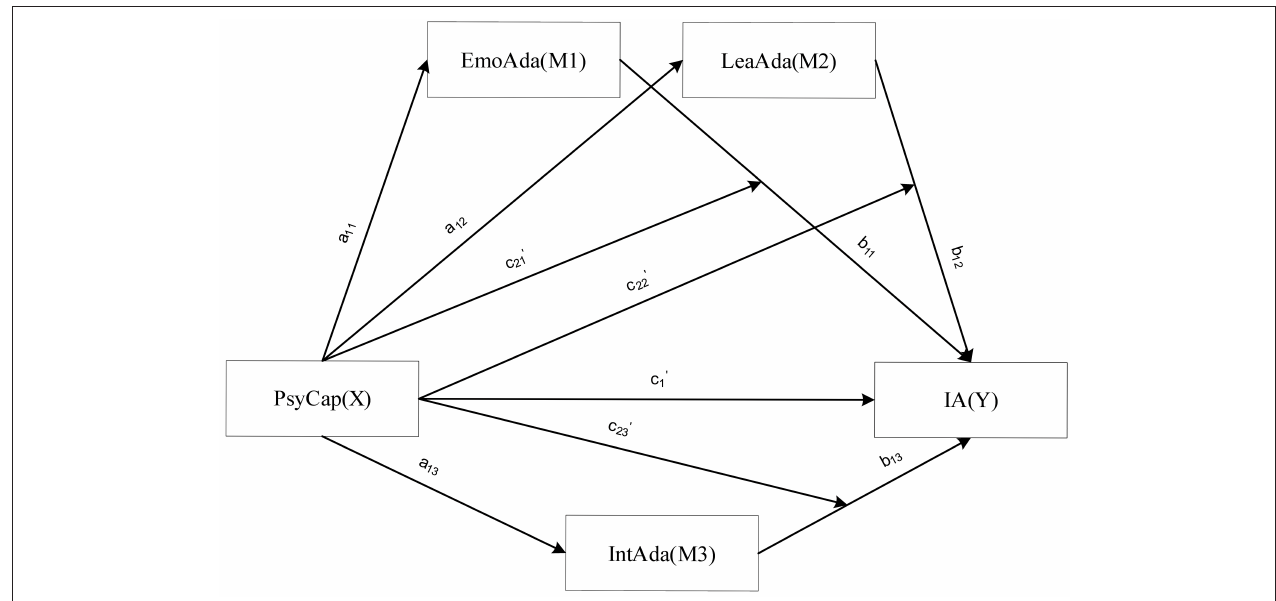
FIGURE 1 | Model diagram of moderated mediation